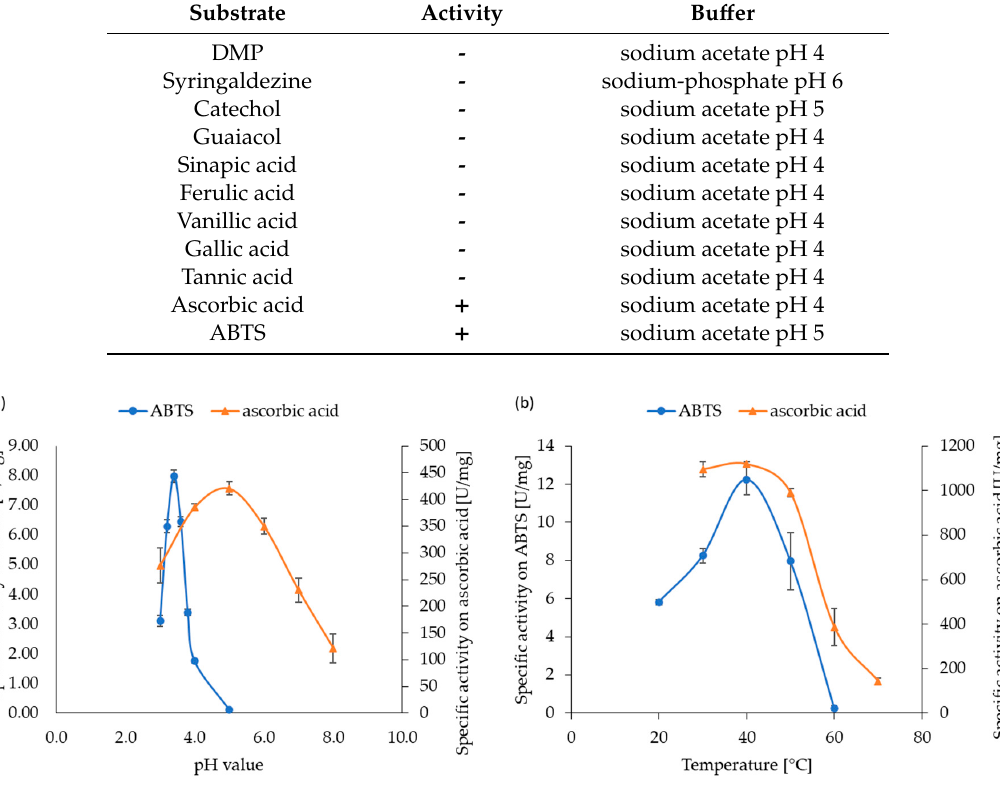
Table 1. Substrate screening: Af _AO1 converted, of all tested substrates, only ascorbic acid and 2,2 ′ - azino-bis(3-ethylbenzthiazoline-6-sulfonic acid) (ABTS). Activity was measured at conditions preferred by each substrate. Activity was determined at 25 °C, except for ascorbic acid, which was measured at 30 °C.